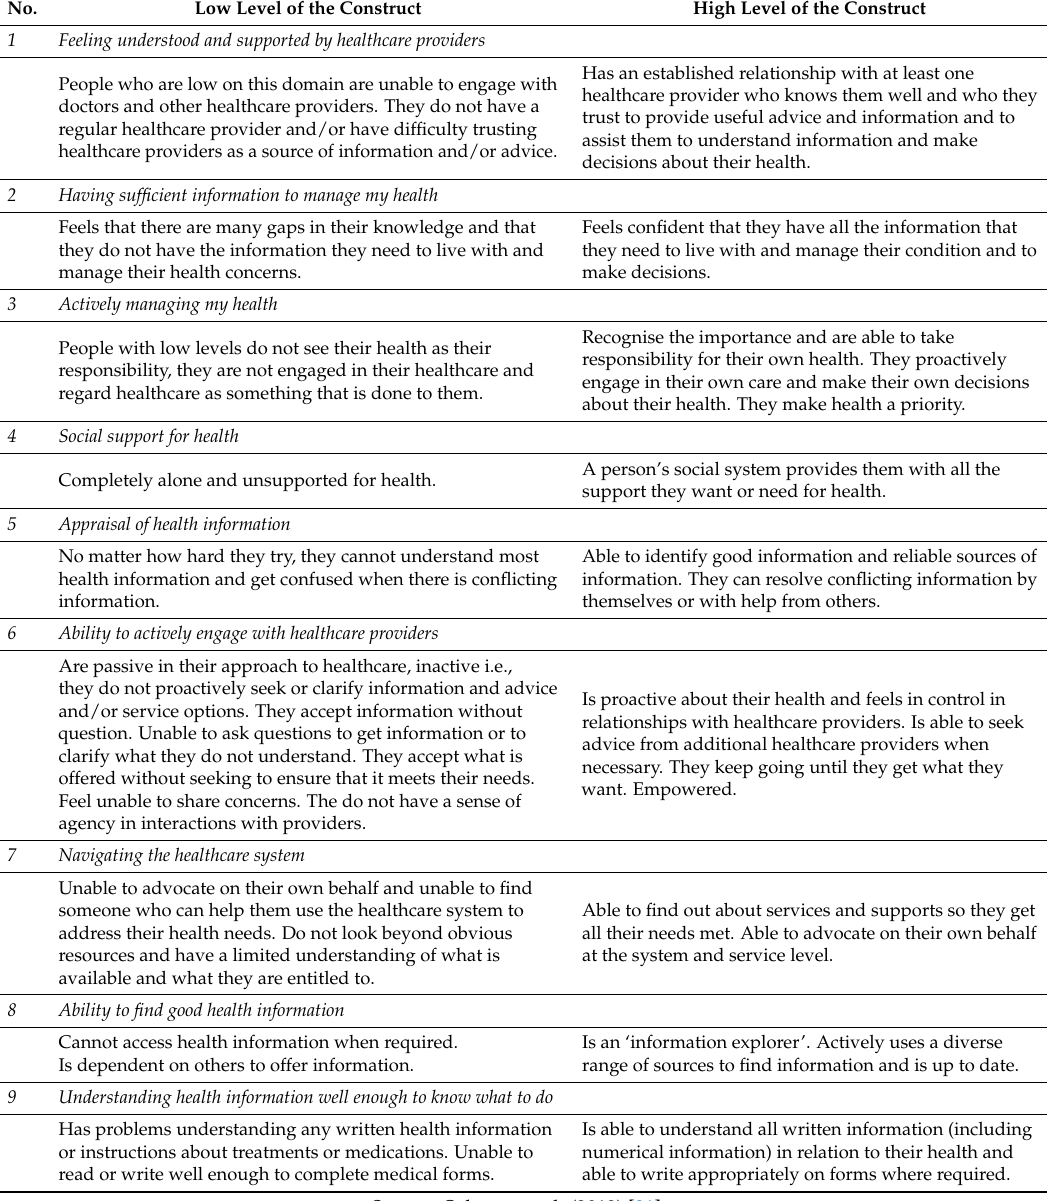
Table 1. Health Literacy Questionnaire (HLQ) domains with high and low